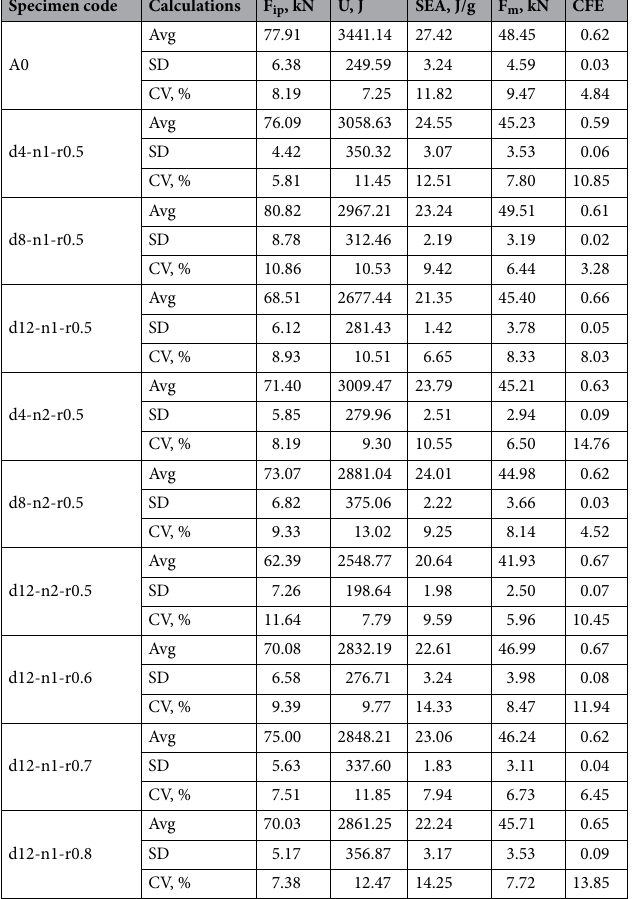
Table 5. Crashworthiness parameters for Al/GFRP thin-walled circular tubes with induced